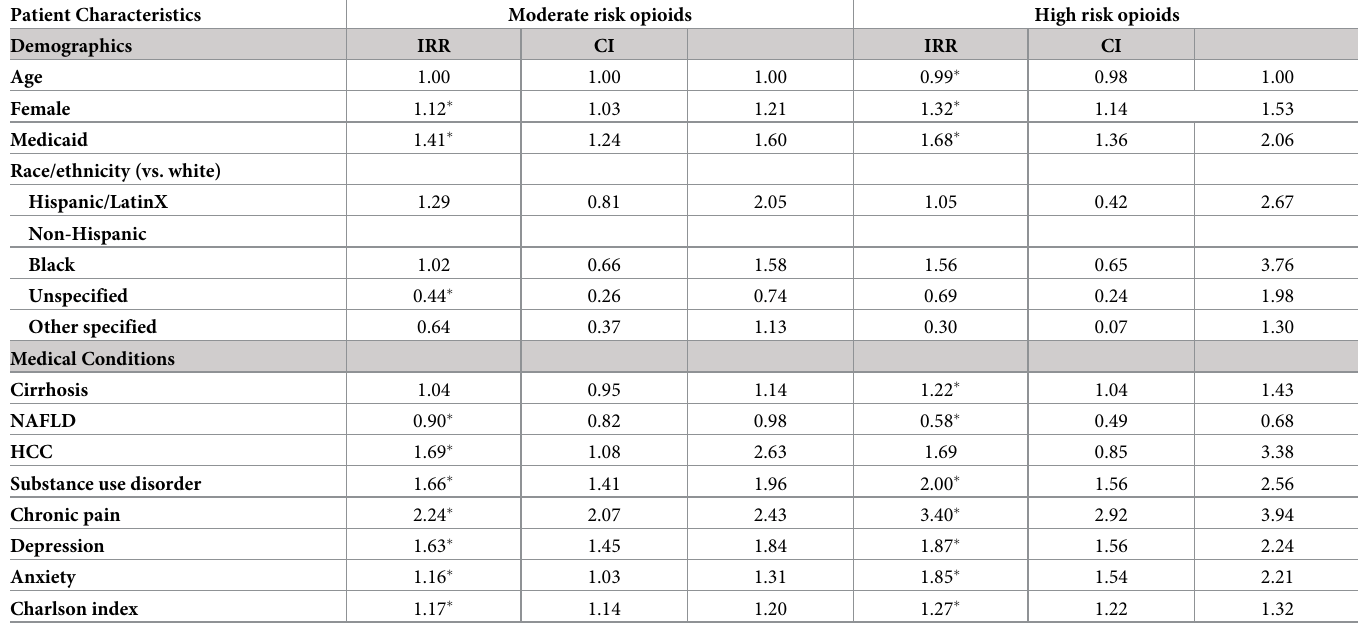
Table 2. Final multivariate multinomial regression model of baseline factors associated with opioid prescriptions �